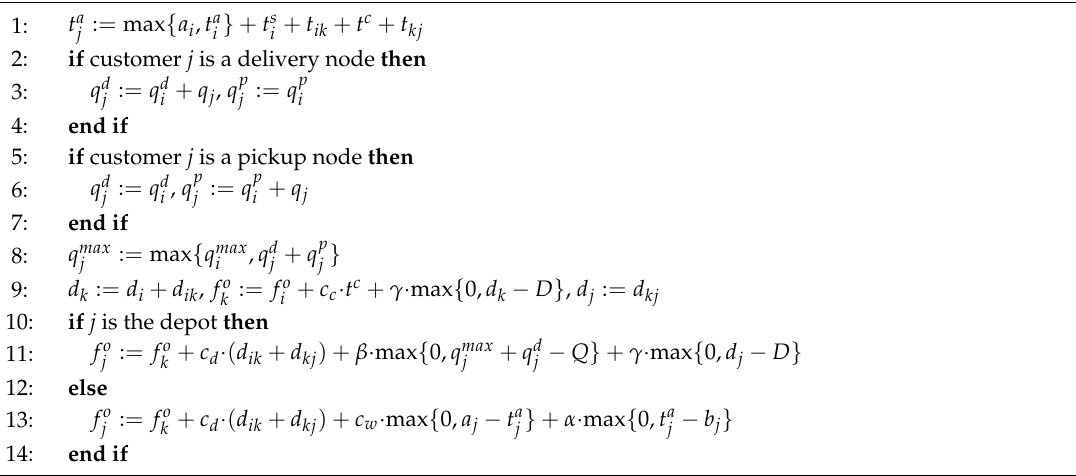
Algorithm 3: Extension rule considering charging stations between a pair of